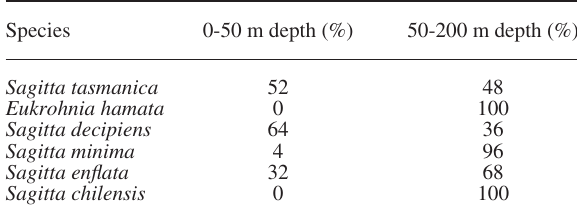
Table 3. – Vertical abundance (%) of chaetognaths between Re- loncaví Fjord and Boca del Guafo. Species